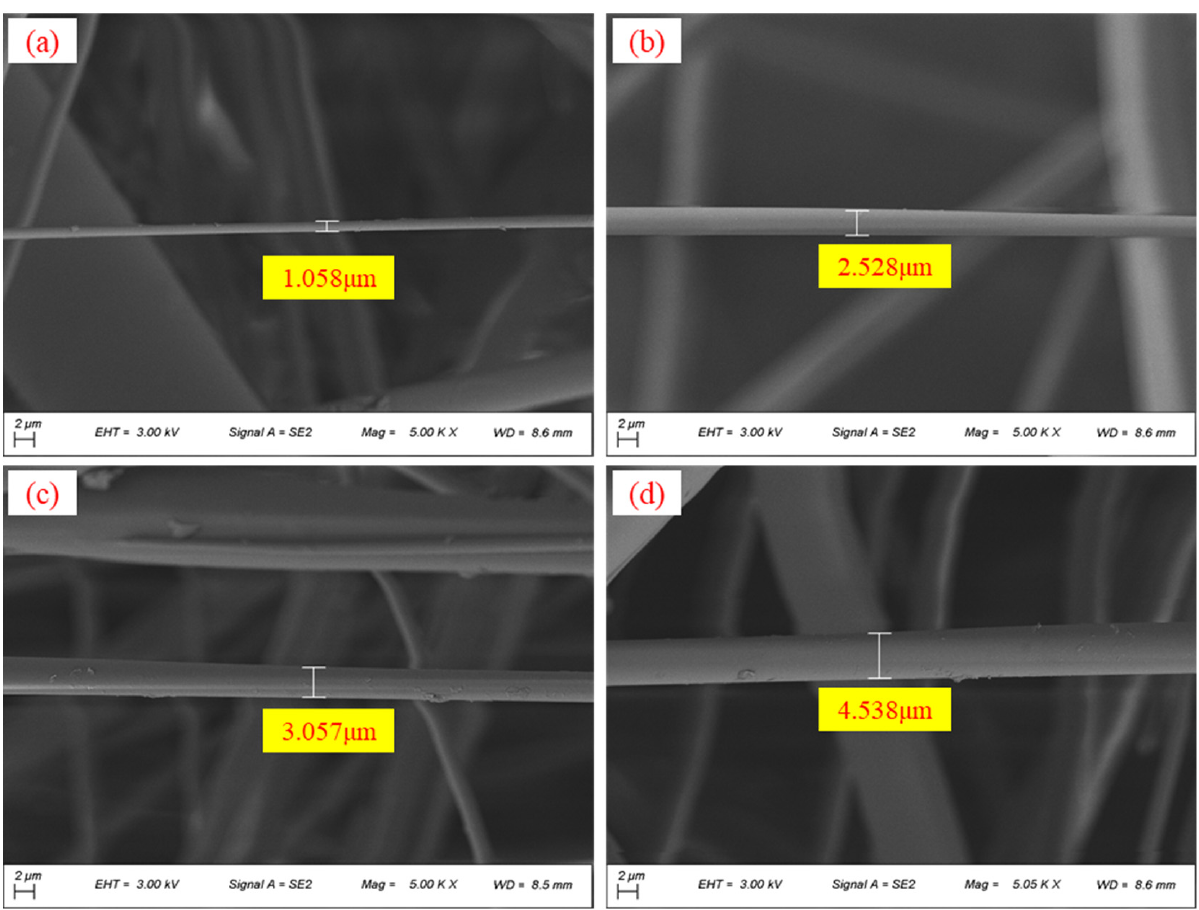
Figure 3. SEM images of ceramic fibers with different diameters.